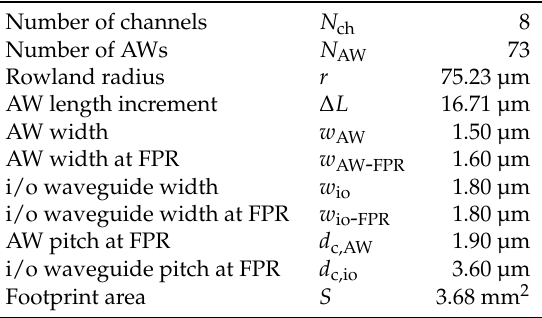
Table 2. Design and layout dimensions for the AWG.